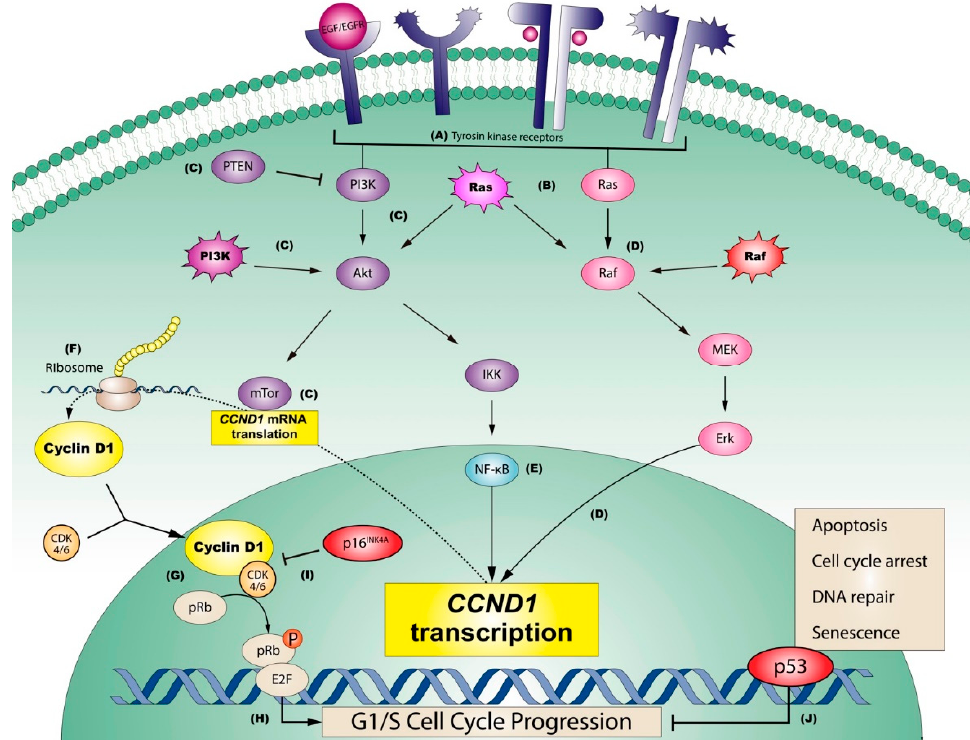
Figure 2. Graphic representation of the most relevant pathways regulating sustaining proliferative signalling in oral squamous cell carcinomas. (A) Tyrosine kinase receptors (e.g., EGFR or ErbB2) may be activated on the cell membrane by extracellular growth factors (e.g., EGF) or by constitutive mutations of the genes that encode them. Consequently, (B) Ras is downstream activated through the stimulation of these receptors, although Ras can be also activated by mutations, representing an influential central point in oral carcinogenesis, able to stimulate two important downstream oncogenic pathways: PI3K (pathway graphically represented in purple colour) and/or MAPK (pathway graphically represented in pink colour). (C) The PI3K pathway (PI3K-Akt-mTor, green), which can be blocked by its potent supressor PTEN (C), regulates the downstream translation of CCND1 mRNA via mTor (C). This pathway can also be constitutively activated by PI3K mutations (C). In parallel, (D) the endpoint of the MAPK pathway (Raf-MEK-Erk; in pink colour), which can also be activated by the constitutive mutation of Raf (D), is the Erk-mediated transcriptional activation of CCND1 (D). A third key pathway in the oncogenic activation of cyclin D1 is (E) NF-kB (in blue colour), which can be activated by IKK, as a consequence of PI3K pathway activation. (F) CCND1 transcriptional activation mediated by ERK, and mTor-mediated translation of its messenger RNA, are both essential for the ribosomal synthesis of cyclin D1, which forms complexes with its binding partners, CDK4/6, that finally translocate to the nucleus. (G) Nuclear Cyclin D1-CDK4/6 complexes subsequently activate the retinoblastoma pathway, in which the release of transcription factors E2F